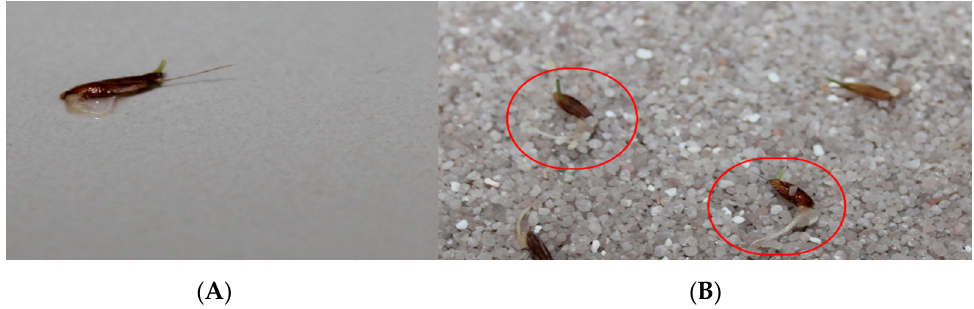
Figure 1. State of development of the A. myosuroides seed at the time of transplantation ( A ). Seeds were placed with the shot upwards on the sand ( B ).